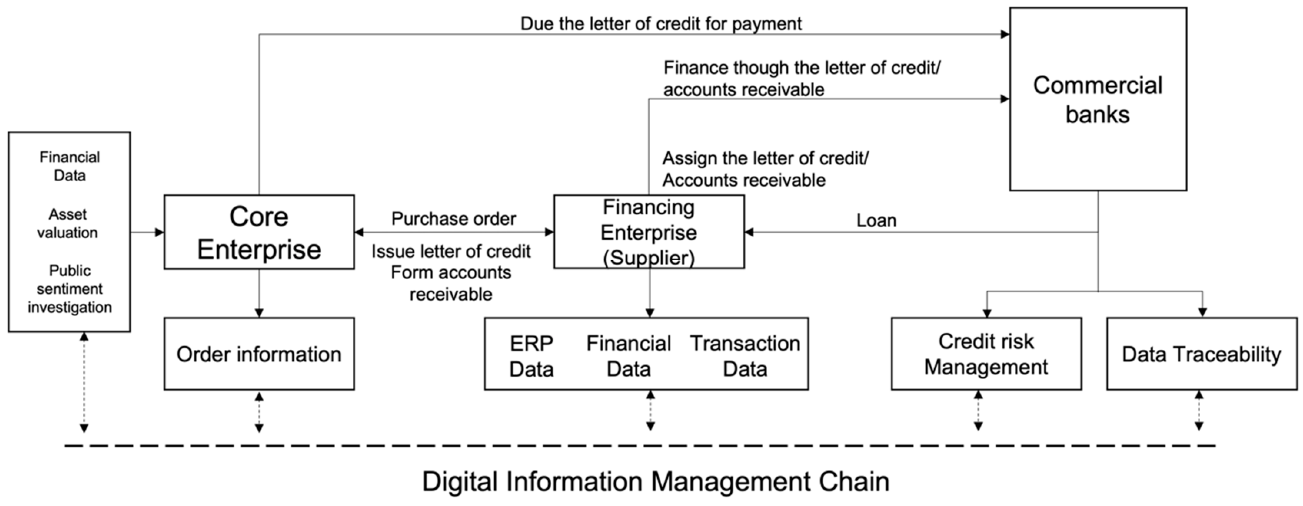
Figure 1. Framework of digital supply chain finance.